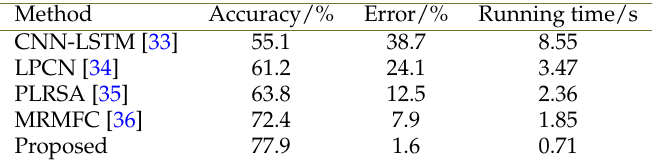
Table 4. Recognition results compared with other